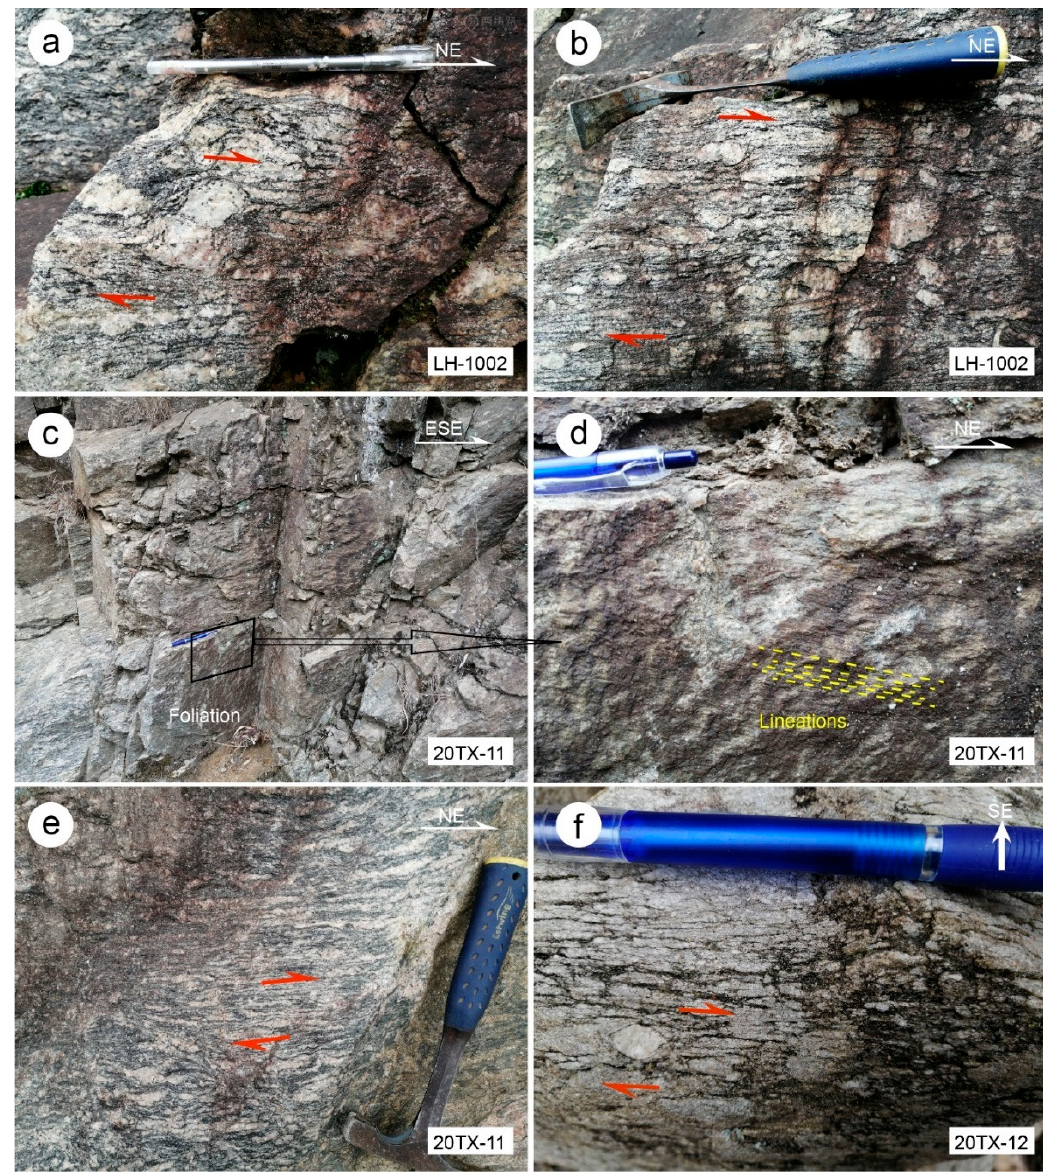
Figure 3. Outcrop photographs of structures in the Wuping–Taoxi shear zone. ( a ) Protomylonite in the Wuping–Taoxi shear zone, containing rotated quartz porphyroclasts that indicate a dextral sense of shear. ( b ) S-C fabrics and rotated quartz porphyroclasts demonstrate a dextral sense of shear. ( c ) Photograph showing high-angle shearing foliation in the Wuping–Taoxi shear zone. ( d ) Stretching lineations defined by elongate quartz and feldspar grains are approximately in a horizontal orientation. ( e ) Rotated feldspar porphyroclasts and S-C fabrics indicate a dextral sense of shear. ( f ) Rotated quartz porphyroclasts demonstrate a dextral sense of shear in the Wuping–Taoxi shear zone. The red arrows show the shear sense.